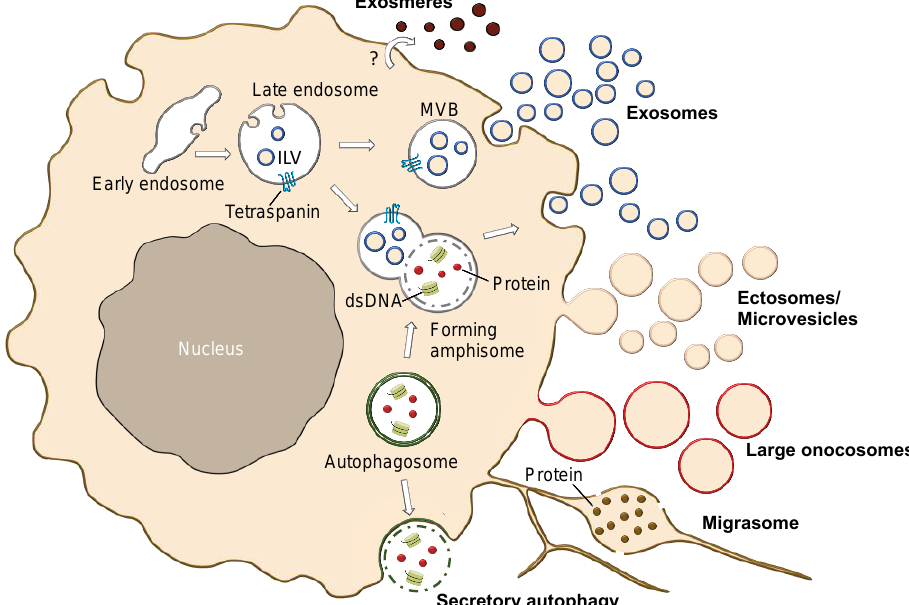
Figure 2. Example of EVs secreted by a melanoma cell. In addition to the traditional EV types (ectosomes, exosomes and apoptotic bodies), a more diverse set of EVs including exomeres, large oncosomes, migrasomes, and EVs derived from secretory autophagy are depicted. ILV refers to intraluminal vesicle; MVB annotates multivesicular bodies; the question mark implies that the biogenesis and secretion of exomeres are largely unexplored to